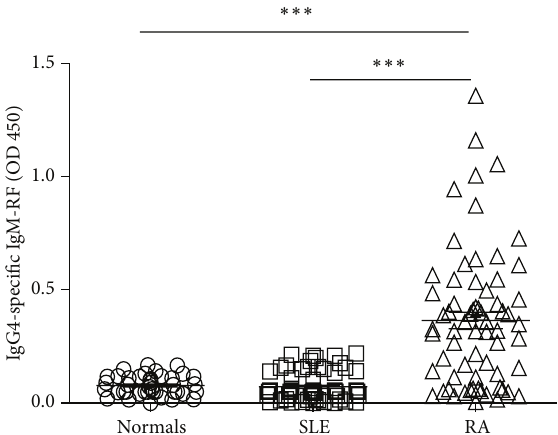
Figure 3: Comparison of serum levels of IgG4-specific IgM-RF in various groups. Detection of IgG4-specific IgM-RF in the serum of normals and SLE and RA patients was conducted by ELISA as described in Section 2 (normal = 41, SLE = 72, and RA = 67; ∗∗∗ 𝑃 < 0.001